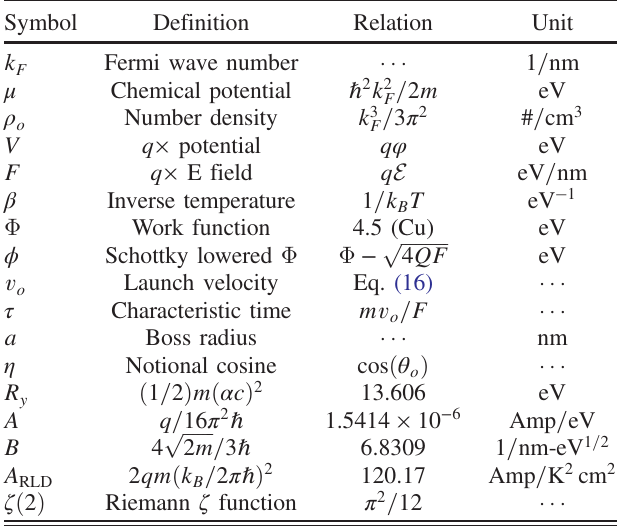
TABLE II. Emission parameters. Terms on which current density depends. R is the Rydberg energy and characteristic y of atomic scales.